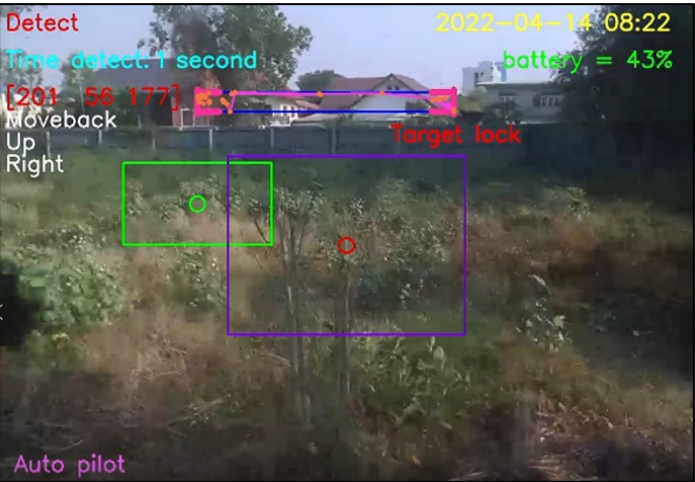
Figure 30. False positive detection.